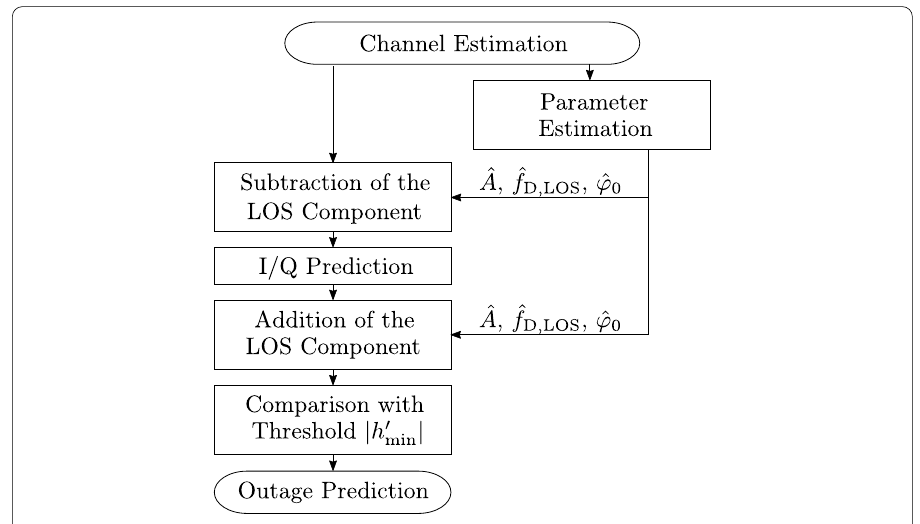
Fig. 7 Structure of the outage predictor for Rician